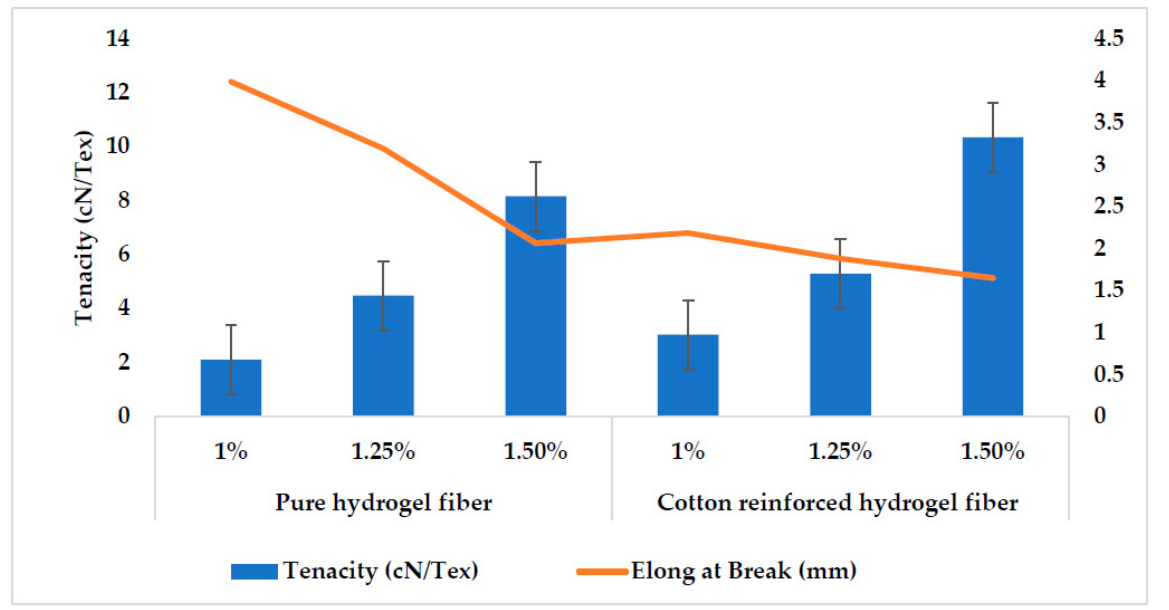
Figure 9. Tensile Strength of pure hydrogel fibers and cotton reinforced hydrogel fibers at different concentrations.